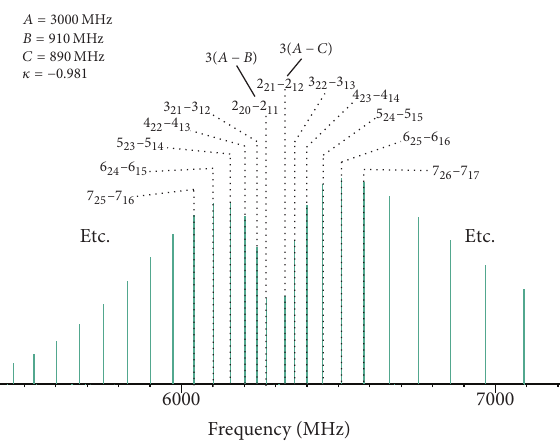
F 8: An example of a tions.